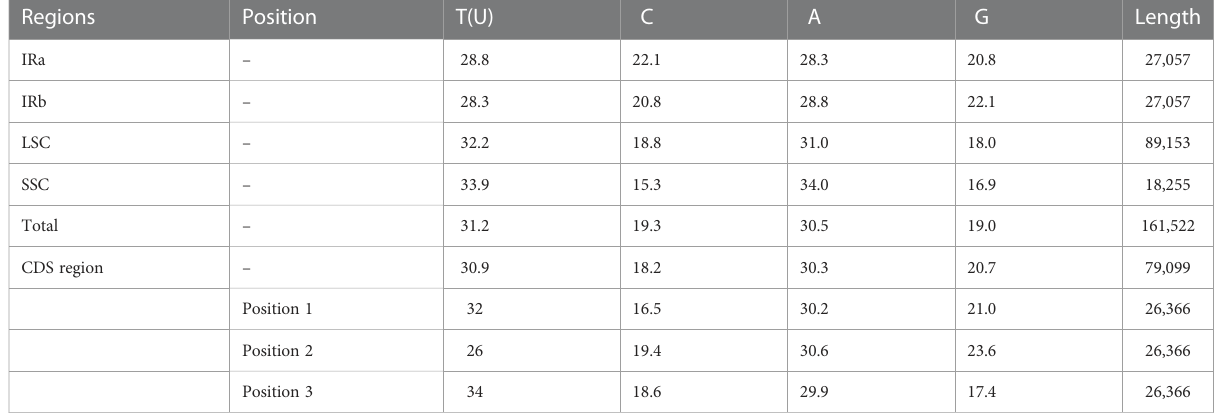
TABLE 2 Nucleotide composition in different regions of the chloroplast genome of Piper nigrum .